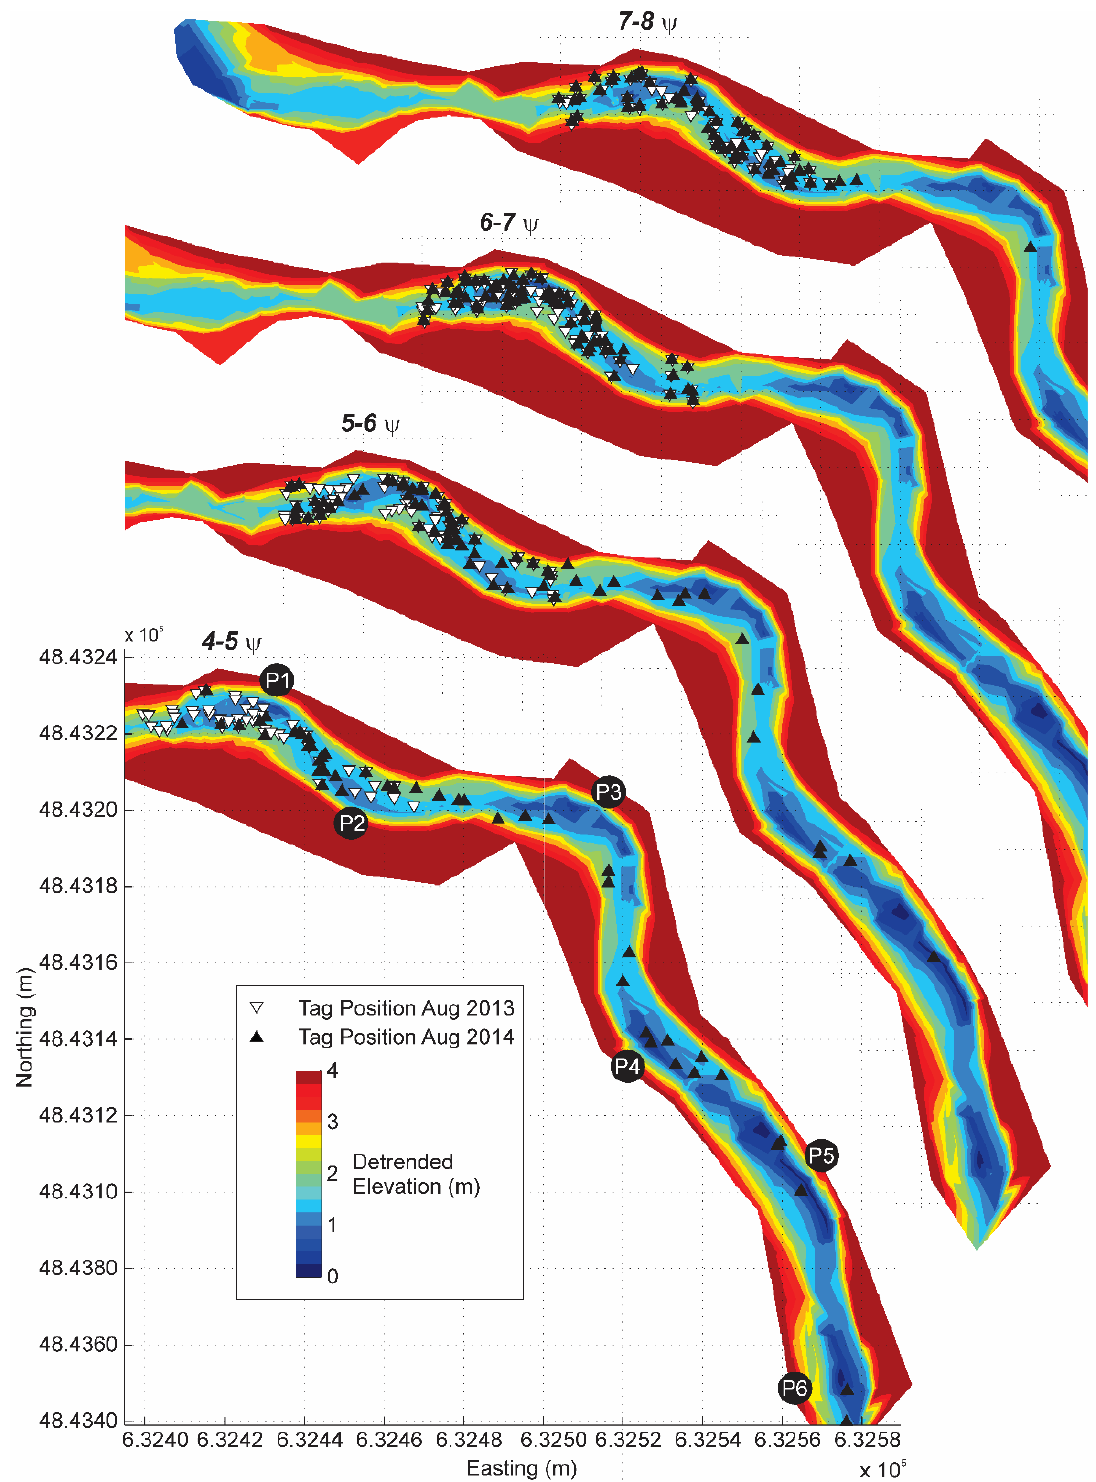
Figure 7. Entrainment and deposition through the restoration reach over 1 year of tracking. The elevation has been detrended by subtracting the overall slope ( S o = 1.12%) of the channel. Grid squares are 20 × 20 m. Pools are numbered from upstream to downstream to facilitate the description of the